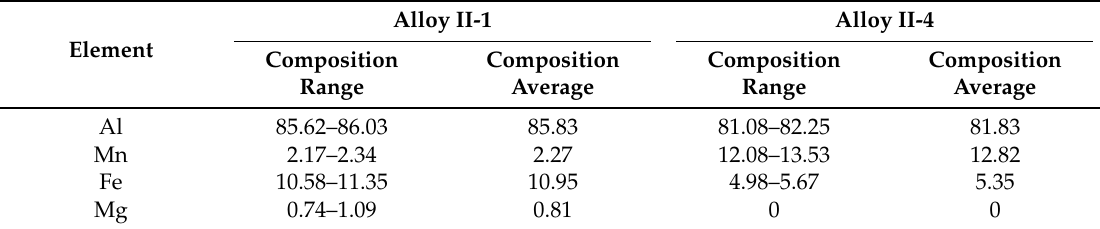
Table 3. Composition of intermetallic Al 6 (Fe,Mn) measured by EDX (at%). Element Alloy II-1 Alloy II-4 Composition Range